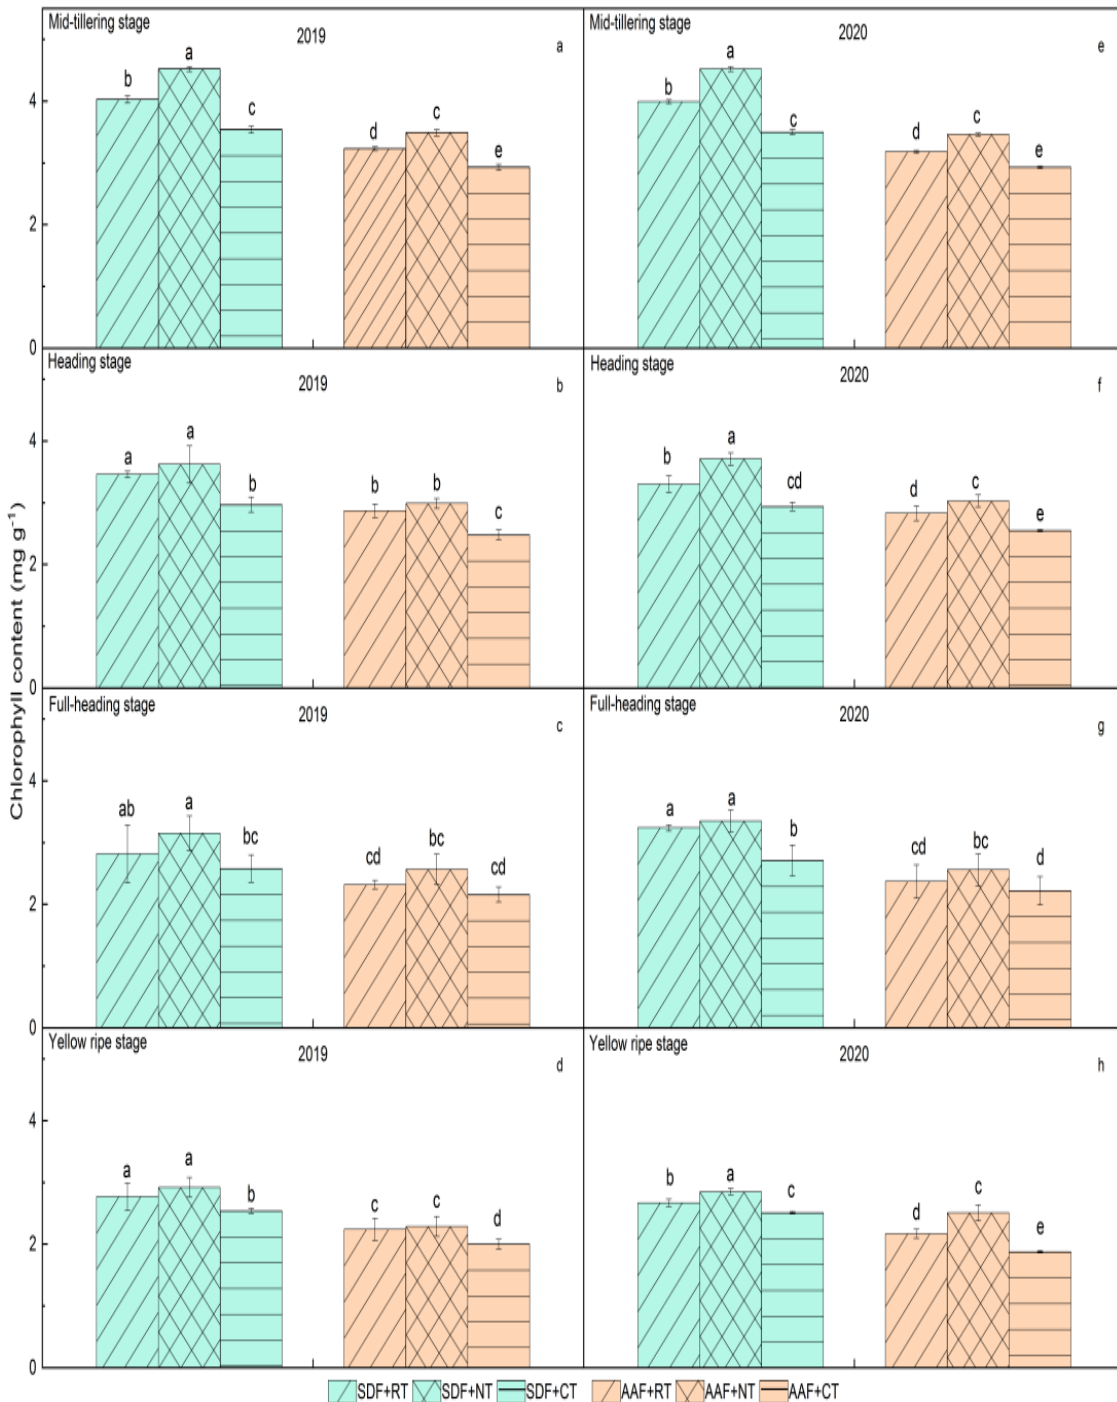
Figure 4. Chlorophyll content at different stages of rice under different tillage and fertilization treatments. ( a – d ) represent the chlorophyll content in mid-tillering stage, heading stage, full-heading stage, and yellow ripe stage in 2019, respectively. ( e – h ) represent the chlorophyll content in mid-tillering stage, heading stage, full-heading stage, and yellow ripe stage in 2020, respectively. Different lowercase letters marked on the histogram mean significant differences among treatments at the 5% level according to Duncan’s multiple-range test (0.05) (similarly hereinafter).